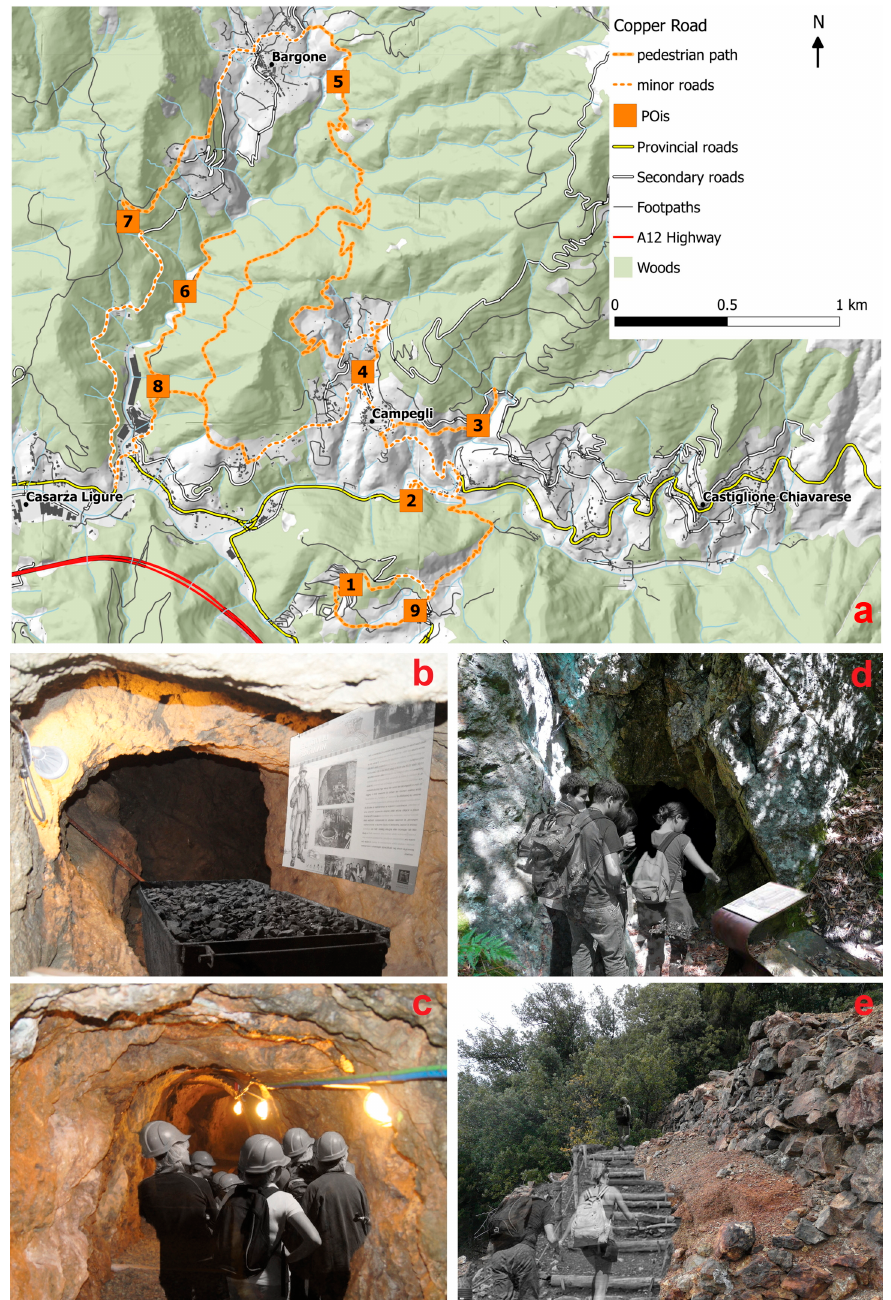
Figure 8. ( a ) map with the suggested itineraries of the “Copper Road” (main points of interest (POIs): (1) Monte Loreto mine; (2) I Casali mine; (3) Rio Bansigo mine; (4) Sant’Elena mine; (5) Bargone mine; (6) Val di Spine mine; (7) Gallinaria mine; (8) water catchment channel and historical mining plants; (9) archaeological and mining museum of Castiglione Chiavarese). ( b – e ) Examples of graphical reconstruction of selected POIs with explanatory panels along footpaths and recovered mining equipment: ( b , c ) accessible mine galleries at the archaeological and mining museum of Castiglione Chiavarese; ( d , e ) accessible mine gallery and footpath through a waste-rock dump at Rio Bansigo mine.